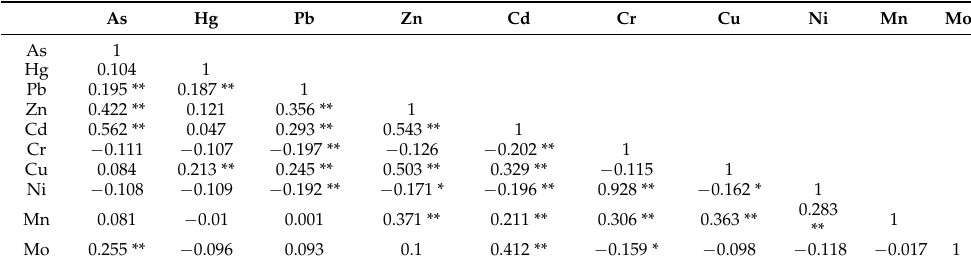
Table 4. Correlation coefficients among the heavy